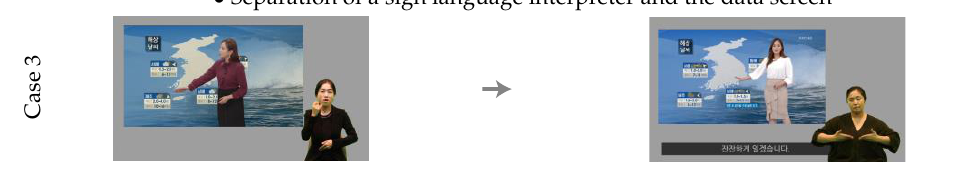
Table 2. Experiment design for news.